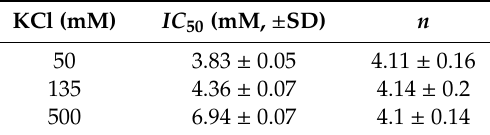
Figure 15. Ionic screening reduces ATP inhibitory e ff ects. The relative conductance indicates that increased ionic screening elicited by addition of KCl minimize the conductance changes induced by ATP addition. The continuous lines represent the fit with the Hill equation (Equation (2)). Adapted from [59], with permission. Table 2. Fit values of IC 50 and n for ionic screening e ff ects on ATP inhibition of lysenin channel